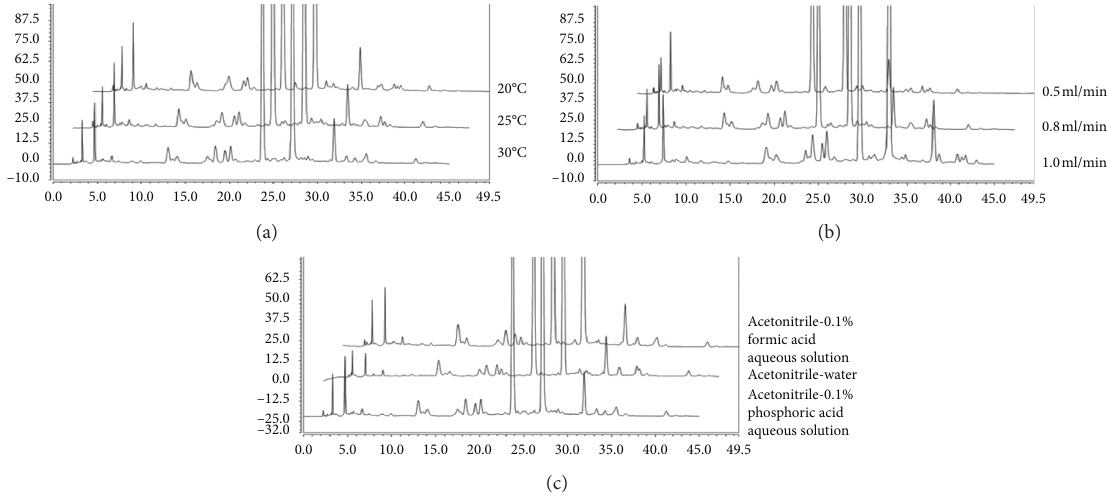
Figure 4: Optimization of chromatographic conditions. (a) Column temperature (20, 25, and 30 ° C). (b) Flow rate (0.5, 0.8, and 1.0mL/min). (c) Mobile phase (acetonitrile-0.1% formic acid aqueous solution, acetonitrile-water, and acetonitrile-0.1% phosphoric acid aqueous